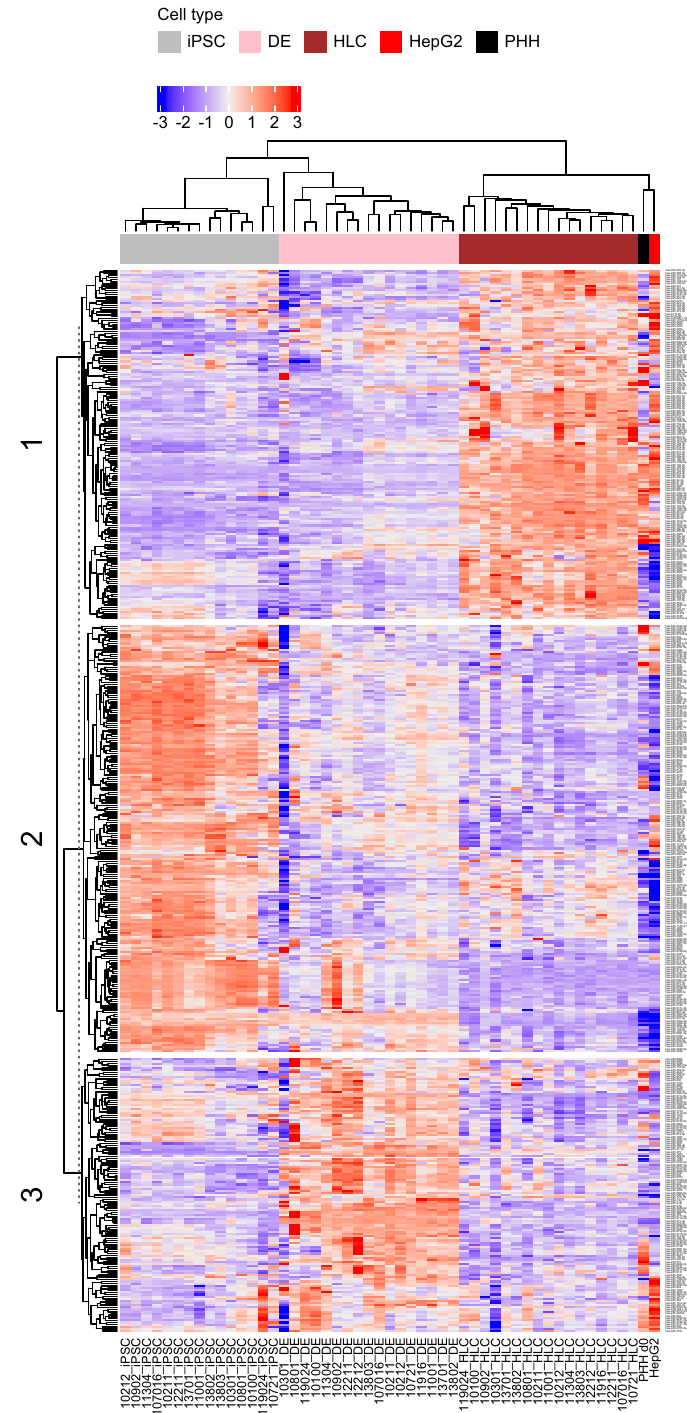
Figure 1. The miRNA expression profile changes during hepatocyte differentiation from iPSCs through DE to HLCs. Heatmap includes differentially expressed (FDR < 0.05) miRNAs between differentiation stages as well as miRNAs expressed only in one or two differentiation stages. Clusters 1, 2 and 3 represent miRNAs that were specific to HLCs, iPSCs and DEs, respectively. The iPSC samples from two cell lines (UTA.11916.EURCSp and UTA.12212.EURCAs) were identified as outliers and excluded from the analysis. iPSC, induced pluripotent stem cells; DE, definitive endoderm; HLC, hepatocyte-like cells; PHH, primary human hepatocyte; HepG2, liver hepatocellular carcinoma cell